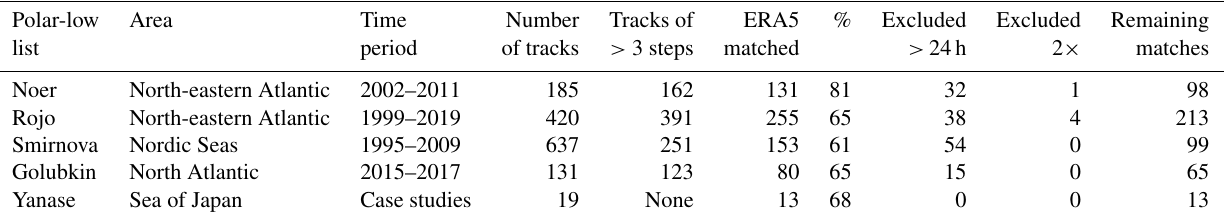
Table 1. Match statistics of PLs from the different lists to ERA5 cyclone tracks. The second and third column summarize the area and time period, respectively, covered by the list. Column 4 provides the number of PLs in the lists; column 5 provides the number of PL tracks with more than three time steps, considered necessary for a trustworthy matching. The Yanase list is treated differently, since it provides only one track point per PL. The number and fraction of PLs matched by an ERA5 cyclone track are presented in columns 6 and 7, respectively. A match is obtained if the cyclone track is within a distance of 150km of the PL for at least half of the track points of the PL. Column 8 displays the amount of matched cases that are excluded, since they start or end more than 24h earlier or later than the PL from the list. Column 9 shows the number of tracks that are excluded if an ERA5 track matches two PLs from the list. The last column provides the amount of matched PLs included in the parameter